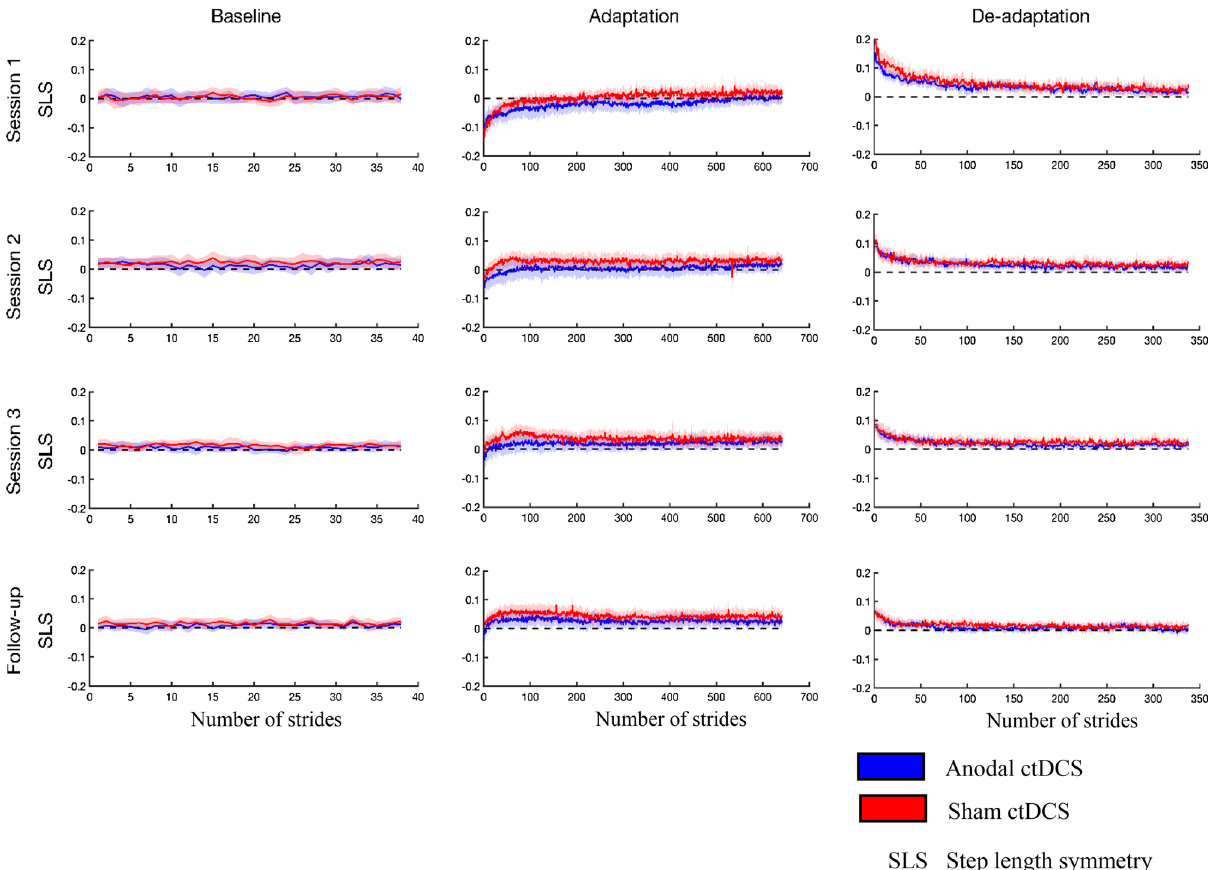
Figure 5. Graphs illustrating the stride-by-stride plots of step length symmetry averaged over all participants in each group across